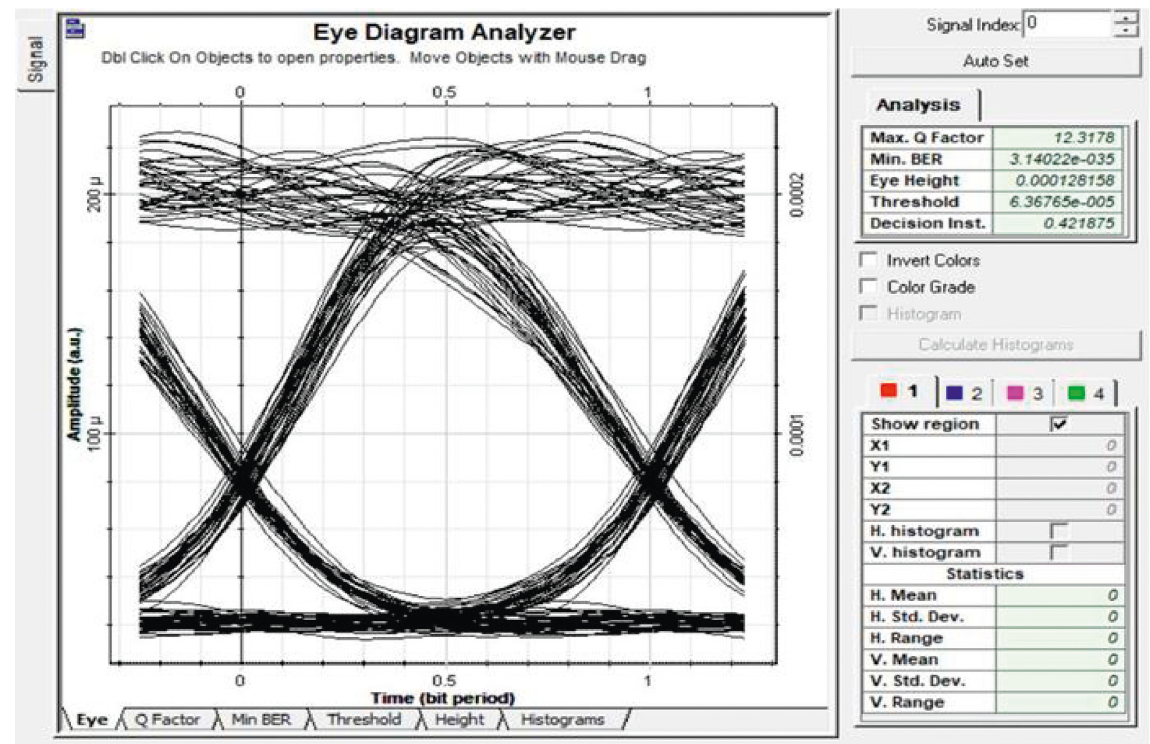
Figure 9: Eye-diagram graphs for three-stage Gaussian-apodized FBG+DCF